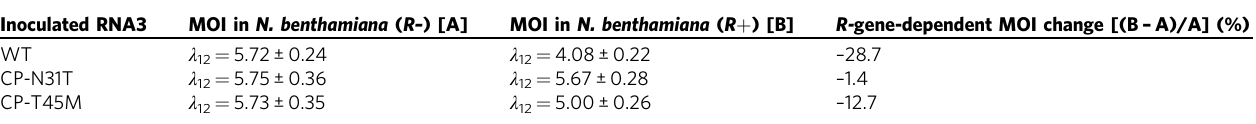
Table 2 Multiplicity of infection (MOI) estimates in wild-type (WT) and RCY1 -transformant Nicotiana benthamiana plants inoculated with WT and variant RNA3s.